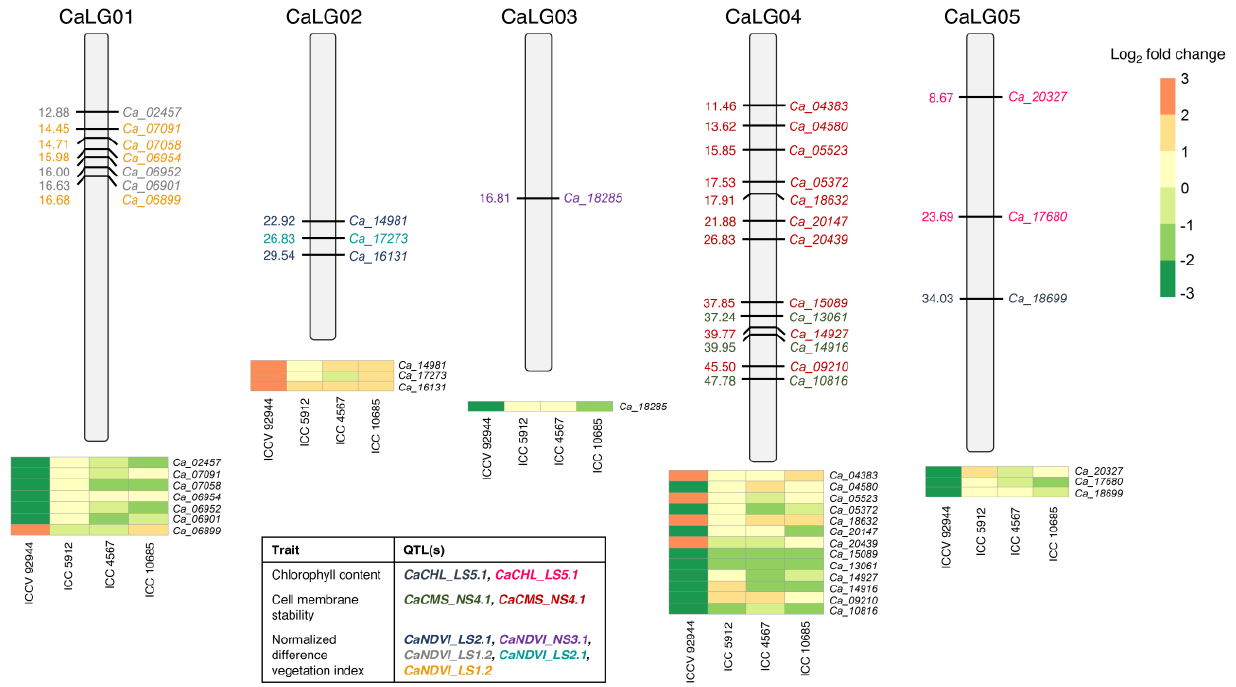
Figure 4. Location of prioritized candidate genes on the chickpea genome and their differential expression profiles in heat-tolerant and -sensitive genotypes. The genomic positions of the prioritized 28 genes underlying the QTLs governing heat tolerance component traits are illustrated. The colored font of the candidate genes corresponds to the QTL(s) identified for three heat tolerance component traits, as demonstrated in the table provided in the bottom-left corner of the figure. Heat maps display the differential expression of the prioritized genes in the leaves of ICCV 92944, ICC 5912, ICC 4567, and ICC 10685, before and after flowering (Supplementary Table S8). The color scale indicates log 2 -fold change.